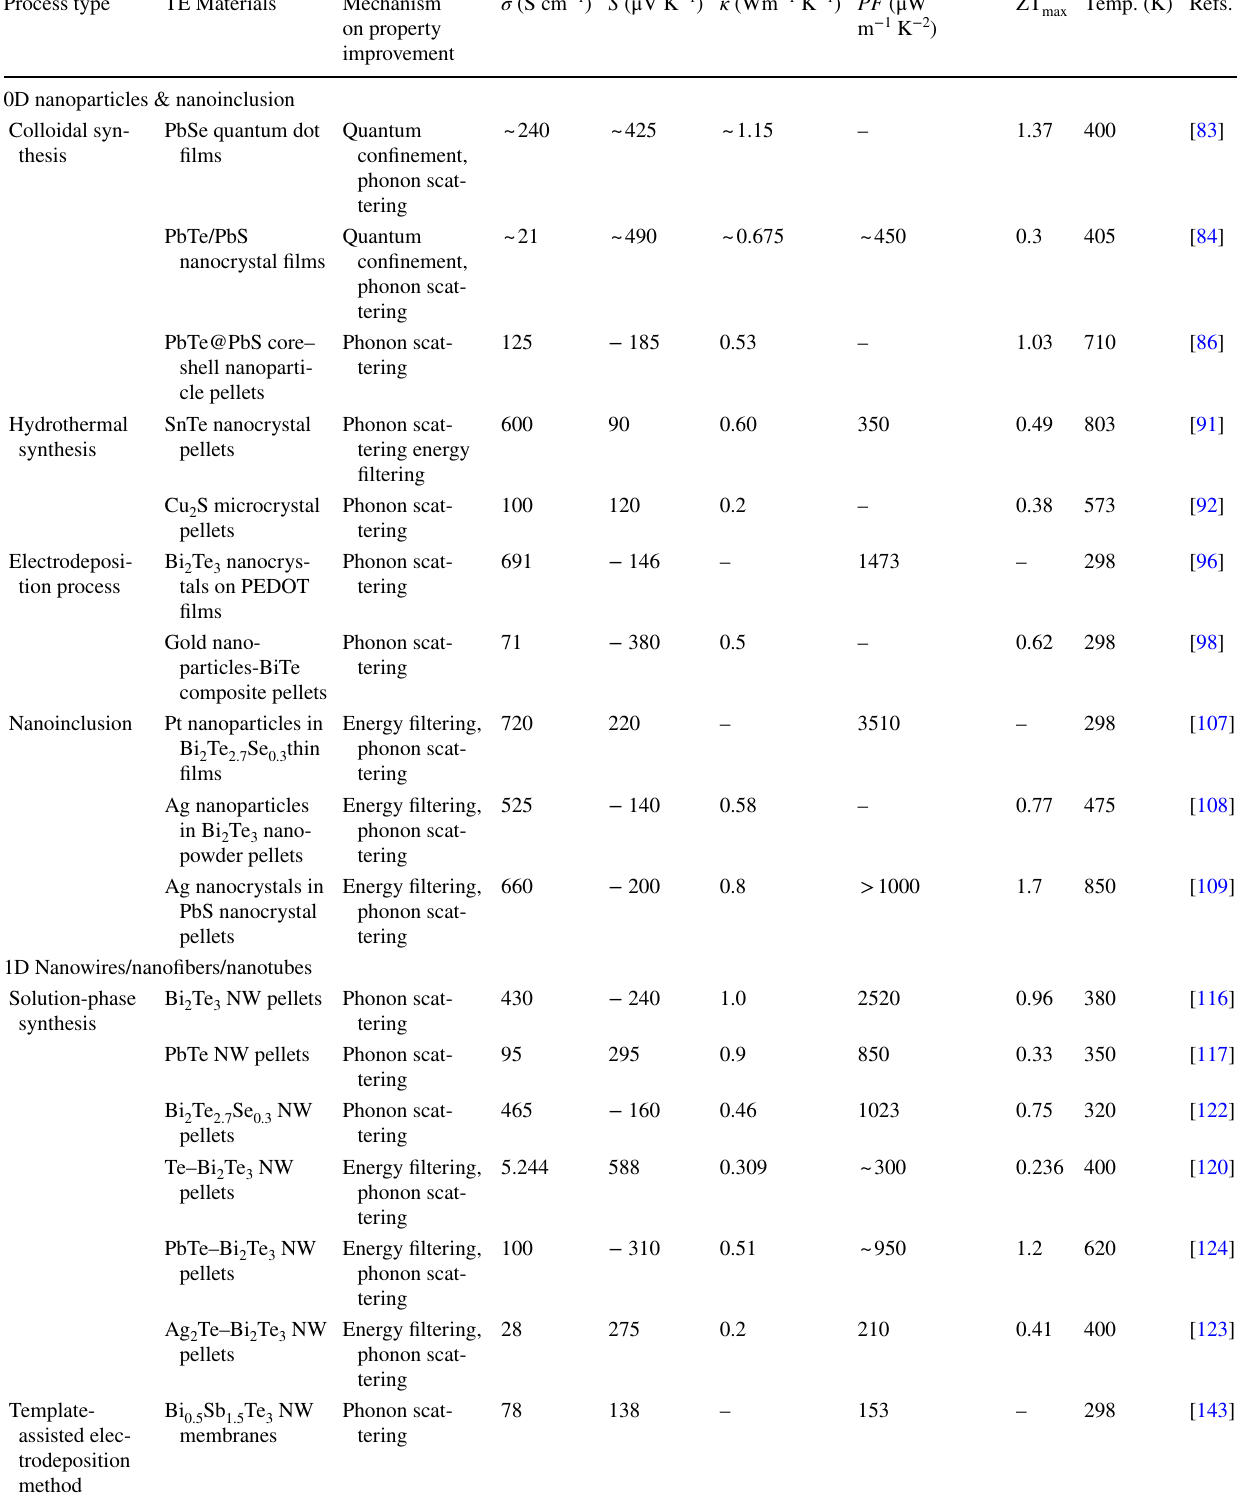
Table 1 Summary of properties of TE materials prepared via various bottom-up methods Process